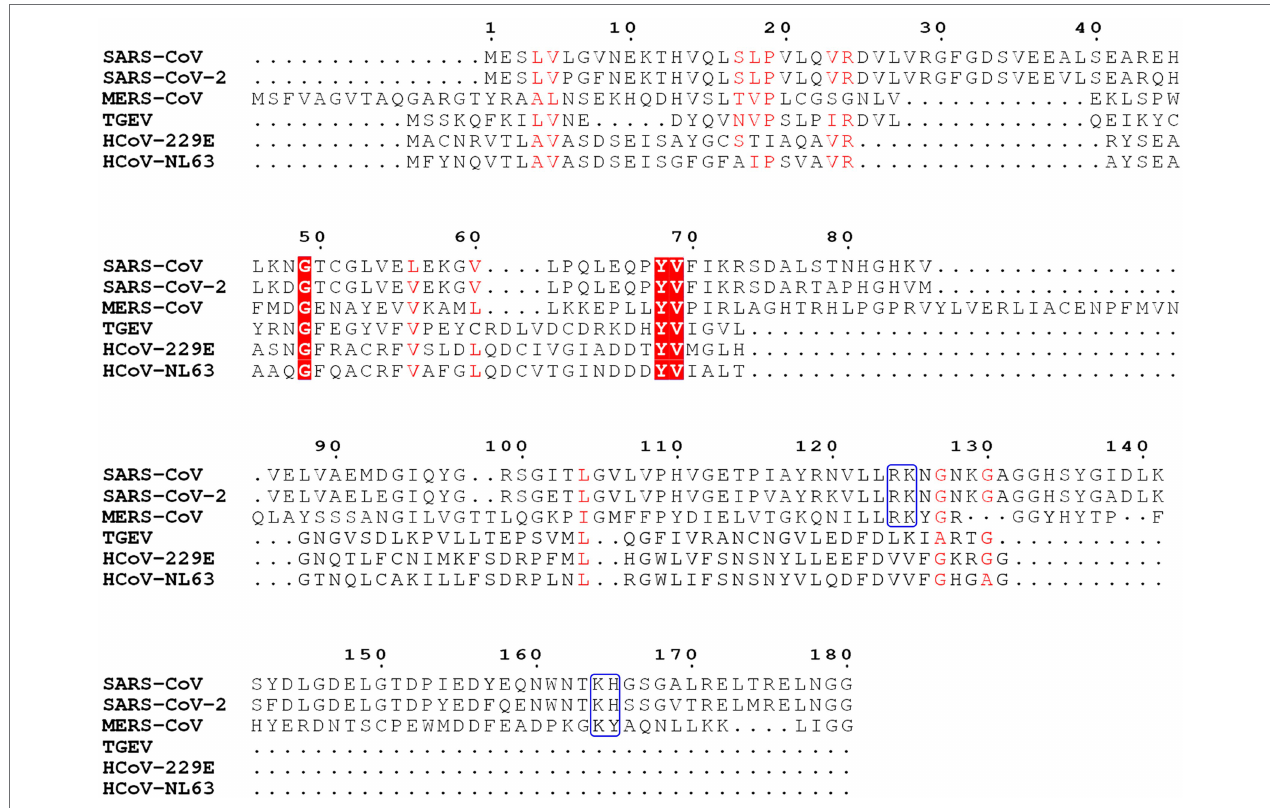
FIGURE 2 | Sequence analysis of Nsp1 from severe acute respiratory syndrome coronavirus (SARS-CoV), severe acute respiratory syndrome coronavirus 2 (SARS- CoV-2), Middle East respiratory syndrome coronavirus (MERS-CoV), transmissible gastroenteritis virus (TGEV), HCoV-229E, and HCoV-NL63. Key conserved residues in SARS-CoV, SARS-CoV-2, and MERS-CoV are labeled with the blue boxes. Conserved residues are labeled in red boxes and shades.